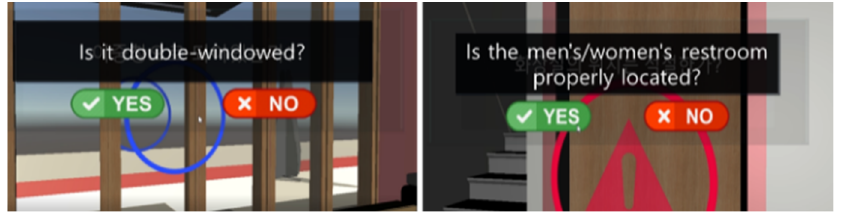
Figure 10. Implementation of floating and checking function.